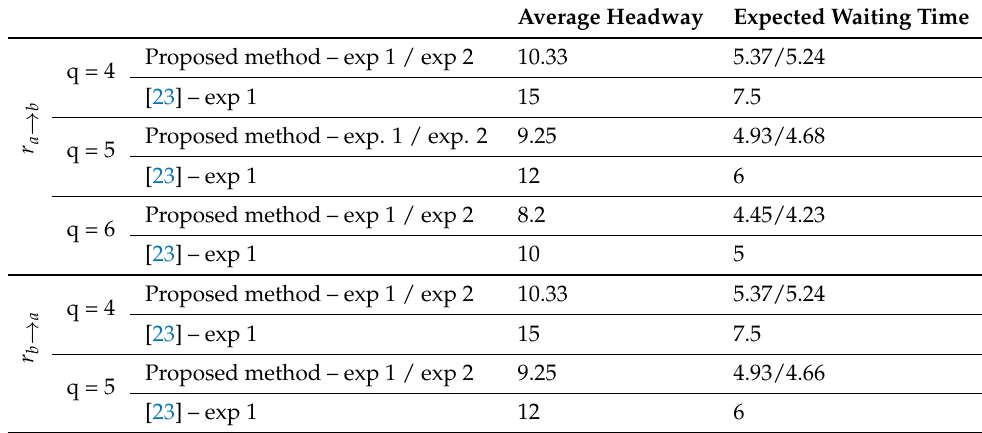
Table 7. Average headway and expected waiting